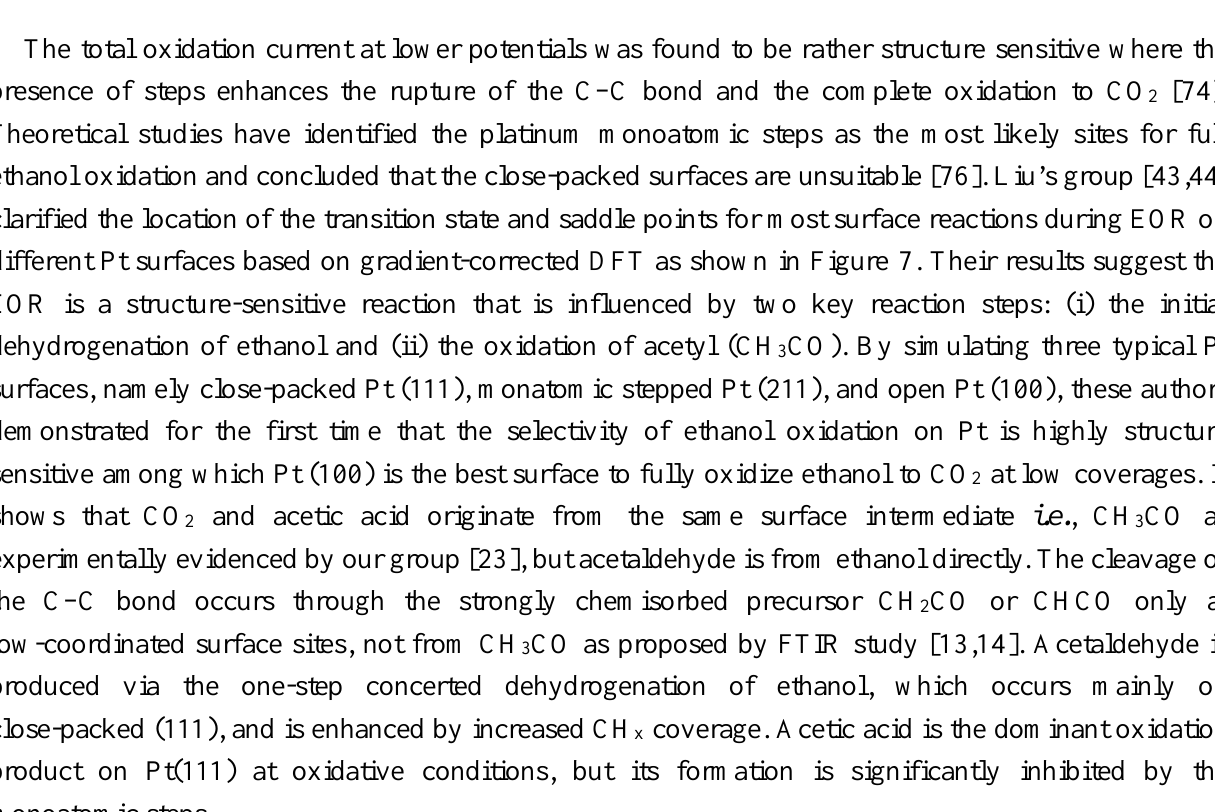
Figure 6. General scheme describing the ethanol oxidation reaction on Pd electrodes in the presence of an electrical double layer proposed by first principle calculations. Reproduced with permission from Reference [39]. Copyright 2014, American Chemical